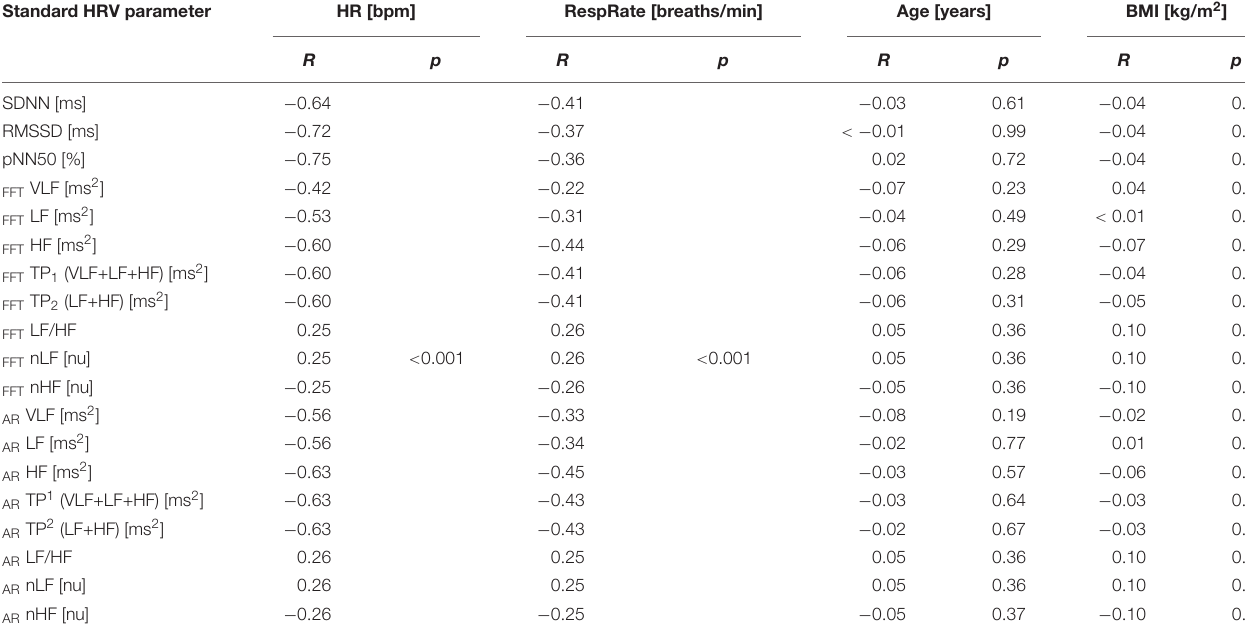
TABLE 1 | Correlations of standard time- and frequency-domain HRV parameters with heart rate, respiratory rate, age, and body mass index. Standard HRV